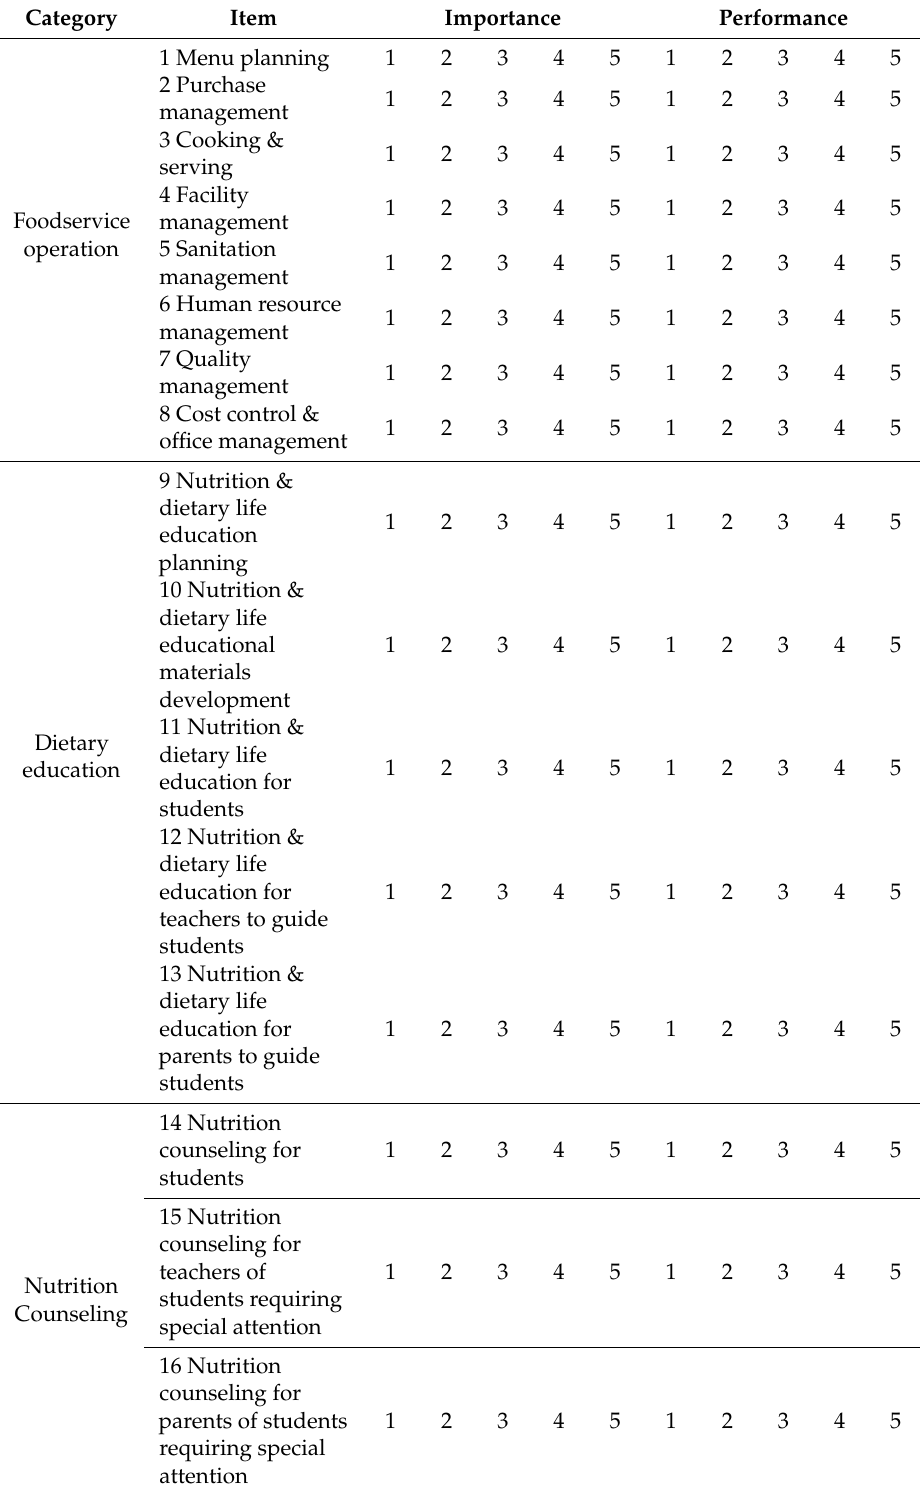
Table A1. Scale items for importance–performance